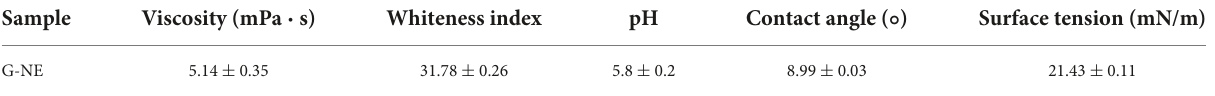
TABLE 2 Physicochemical properties of geraniol nanoemulsion